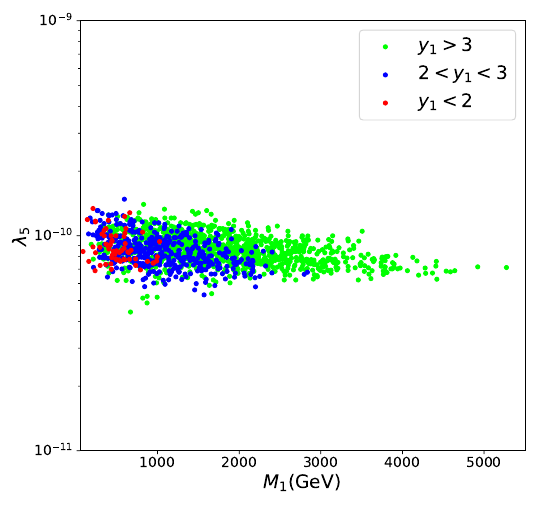
Figure 3 . Same as figure 2, but in the M 1 − λ 5